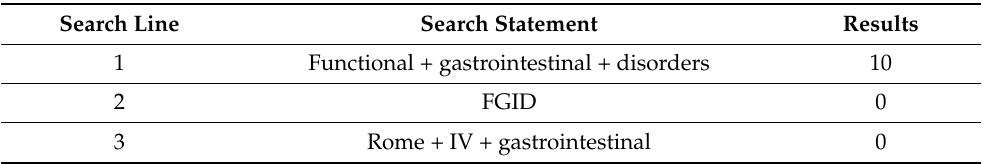
Table A9. OPEN GREY. Search